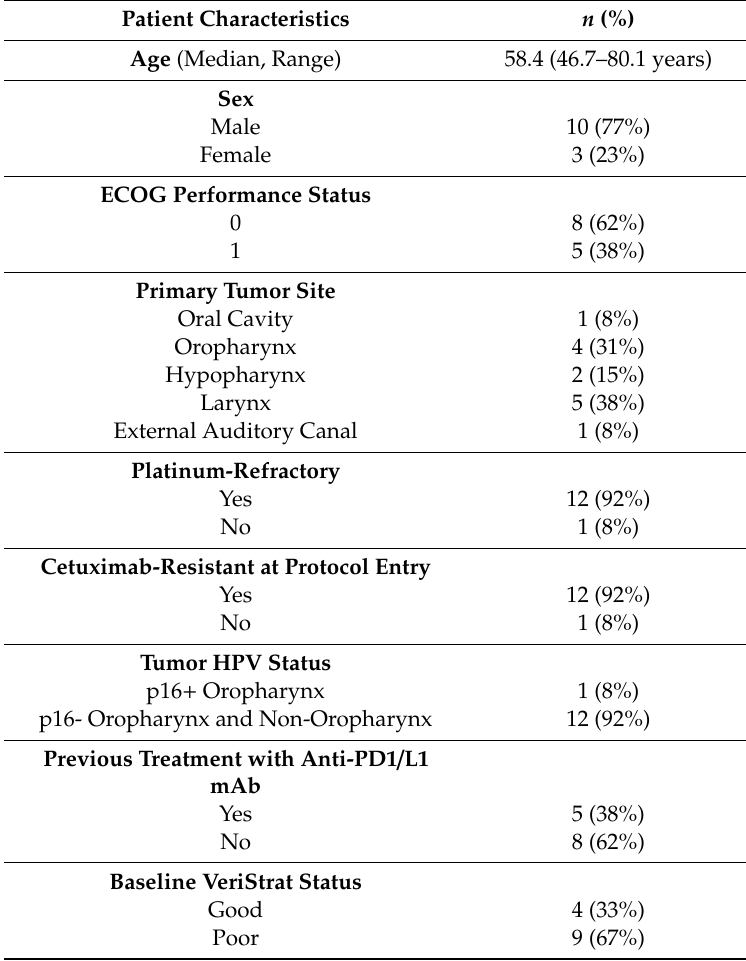
Table 1. Baseline patient demographics and disease